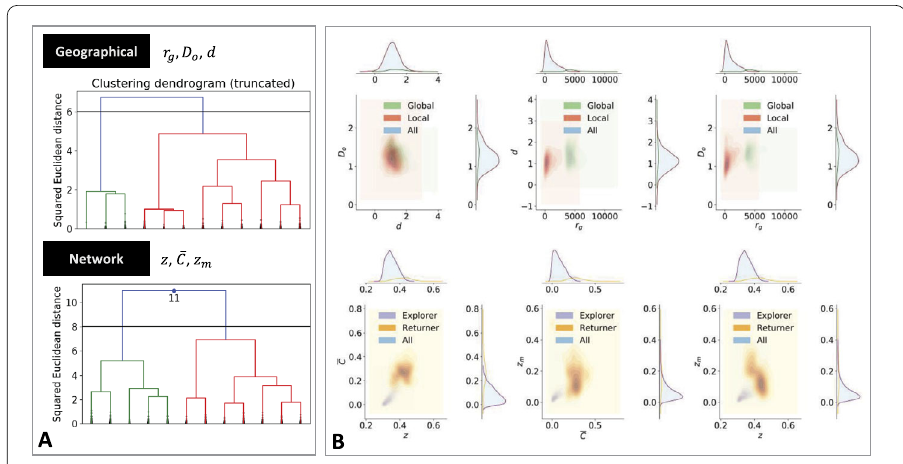
Figure 4 Clustering results. ( A ) Clustering dendrogram. The clusters are formulated by splitting groups into clusters when the cluster distance is above five. ( B ) Kernel density estimation of cluster feature distributions of geographical characteristics and network properties. The height of the one-dimensional distribution is proportional to the fraction of the number of individuals in each cluster over the total individuals. The Silhouette width for both clustering results is above 0.5, indicating that the identified categories are